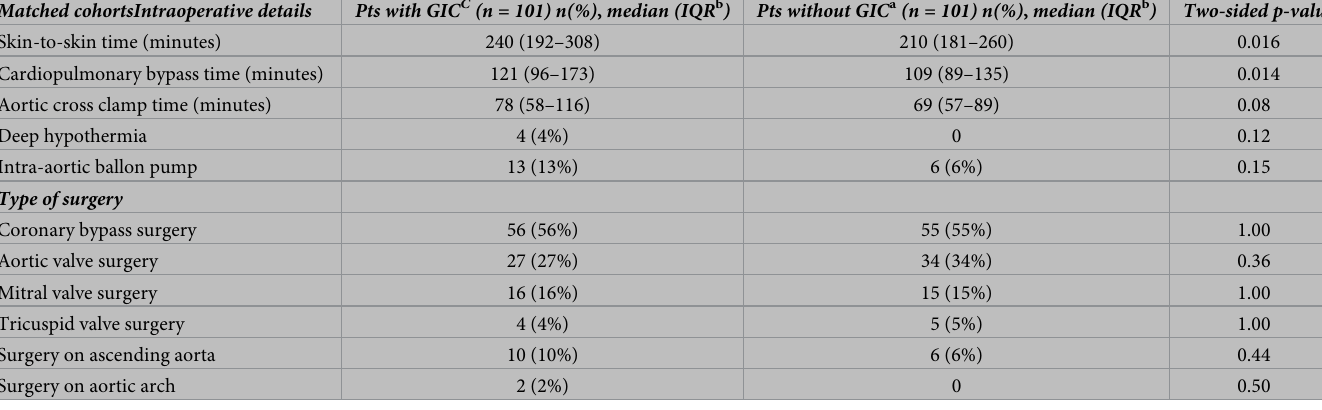
Table 5. Surgical details (matched